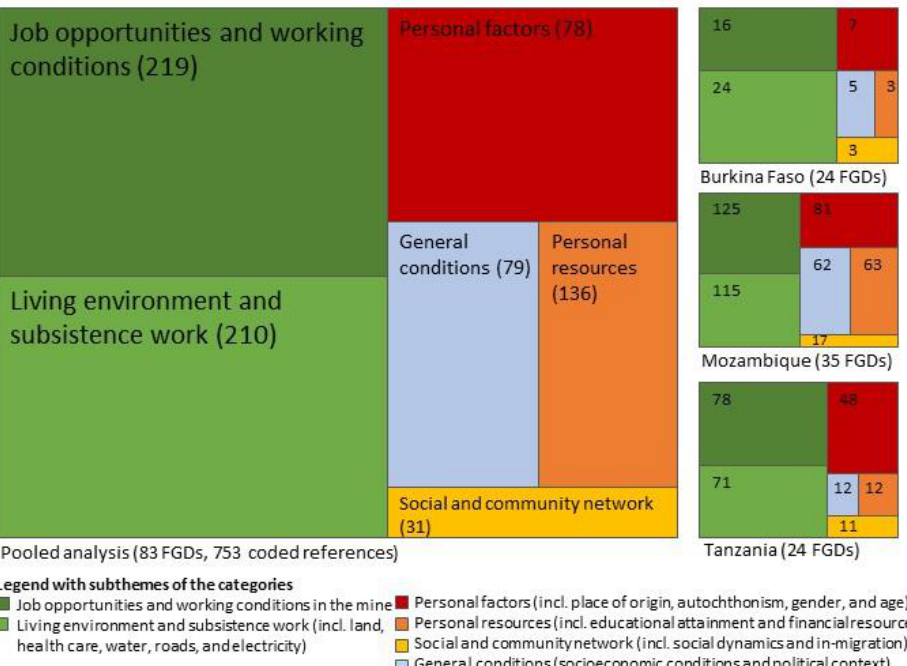
Figure 2. Qualitative tree maps indicating the proportion of coded references (and absolute number in brackets) of perceived inequities and the consistency of findings across countries (FGD: focus group discussion).